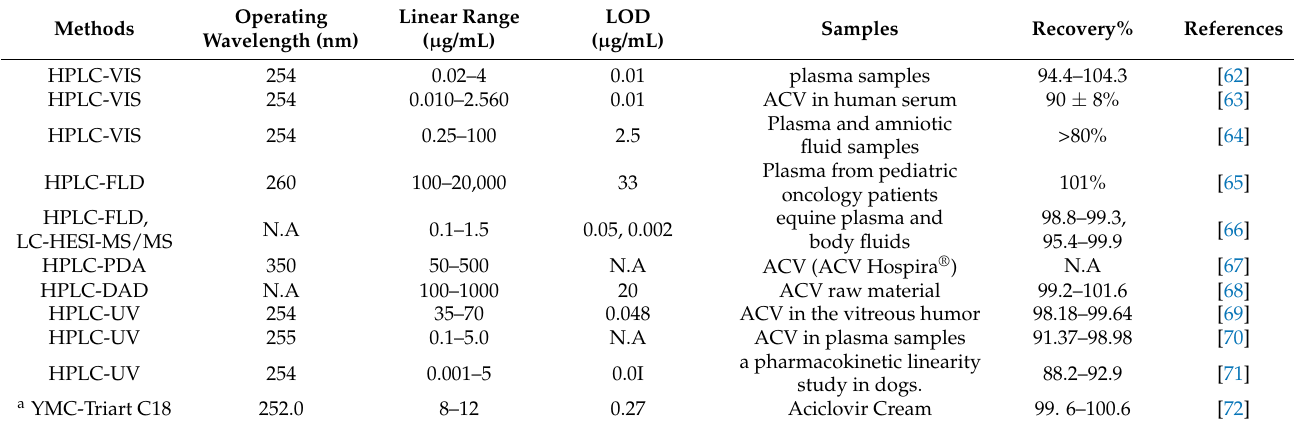
Table 7. Various HPLC methods for the detection of ACV (“N.A”: No data applicable or available).